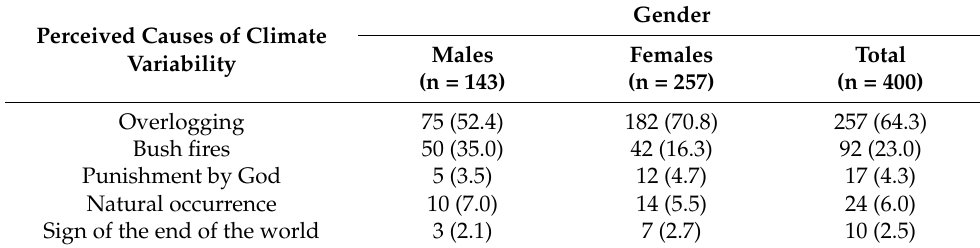
Table 6. The respondents’ perception of the causes of climate